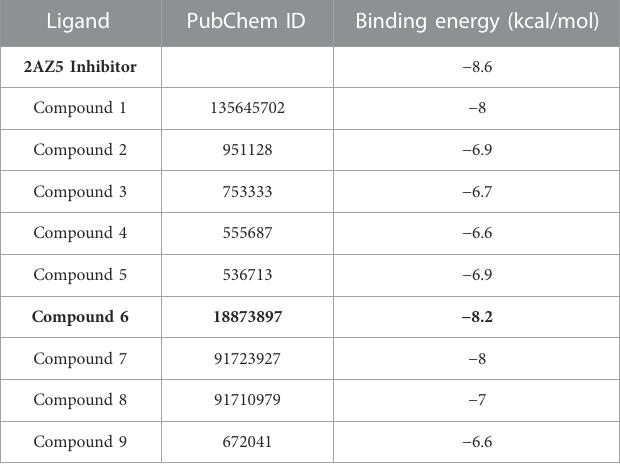
TABLE 3 Molecular docking results for ligands bound to TNF- α receptor